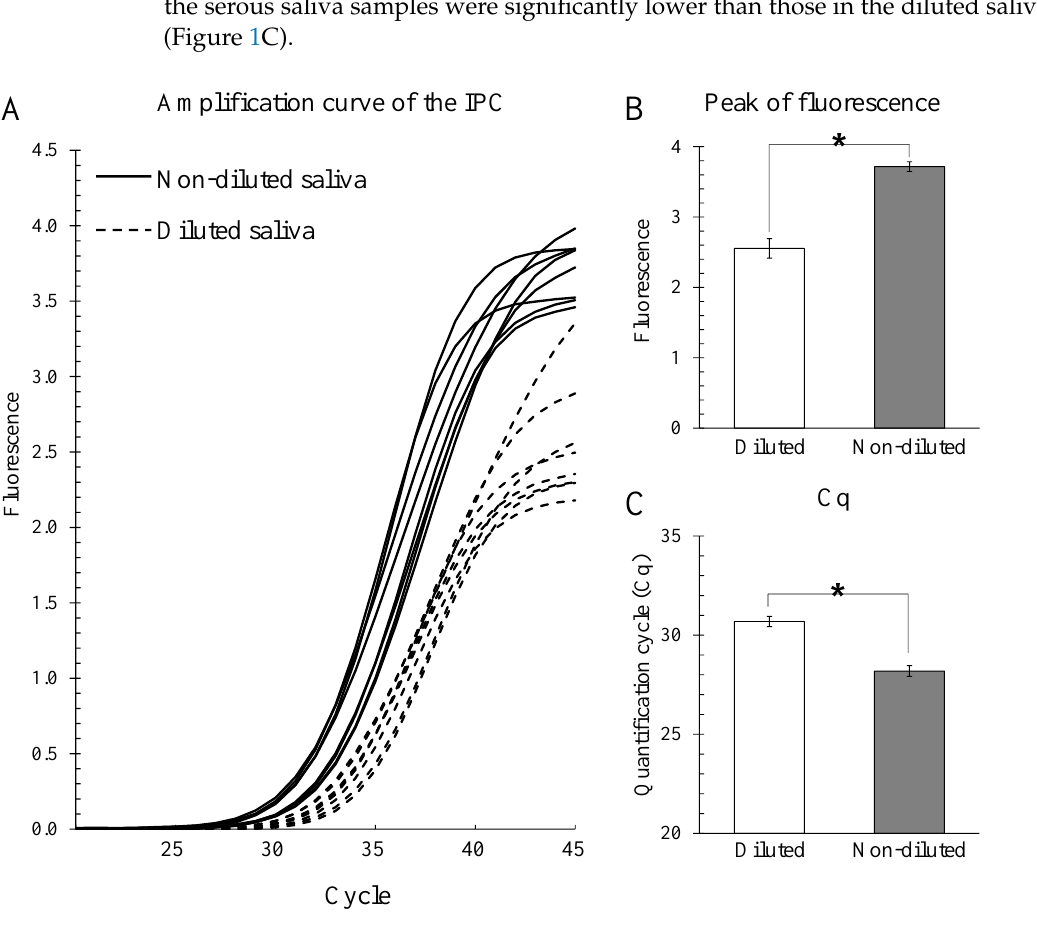
Figure 1. Amplification of the internal positive control (IPC) in diluted and non-diluted saliva. Human saliva samples were collected from eight healthy volunteers. ( A ) Amplification curves of IPC in diluted (dashed line) and non-diluted (solid line) saliva samples. ( B ) Fluorescence intensities of the IPC at the end of each reaction in diluted (open column) and non-diluted (grey column) saliva samples. ( C ) Quantification cycle (Cq) values of the IPC in diluted (open column) and non-diluted (grey column) saliva samples. Data are shown as mean ± SEM ( n = 8). The Mann–Whitney–Wilcoxon test was used to identify a non-parametric significant difference between diluted and non-diluted saliva samples. Asterisks (*) indicate significant differences at p < 0.01 between diluted and non-diluted Figure. 1 Amplification of the internal positive control (IPC) in the diluted and non-diluted saliva